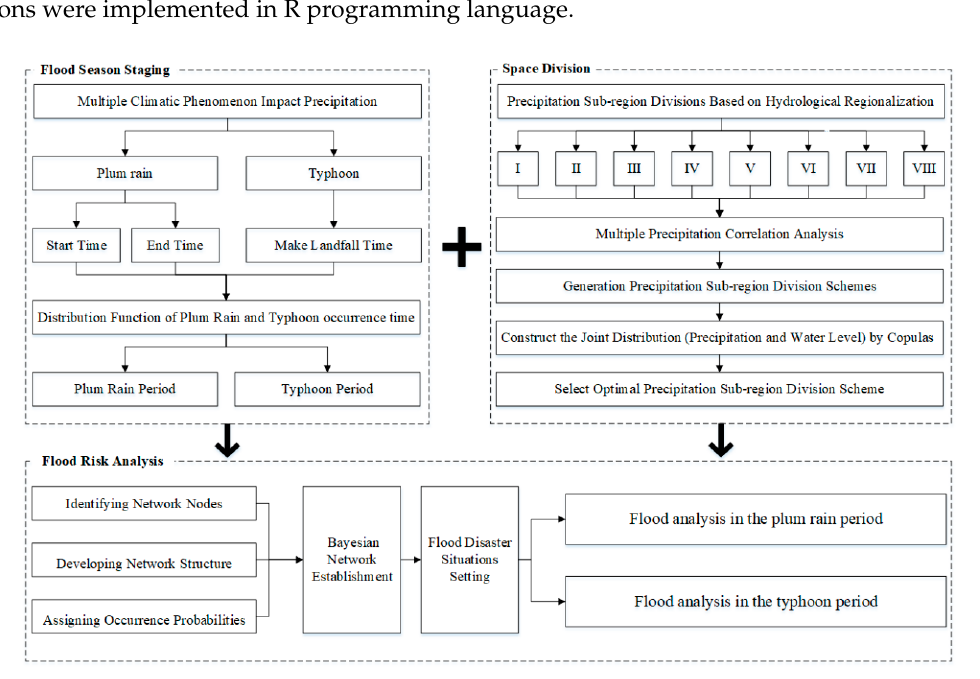
Figure 2. Framework of flood risk analysis of the different climatic phenomena.